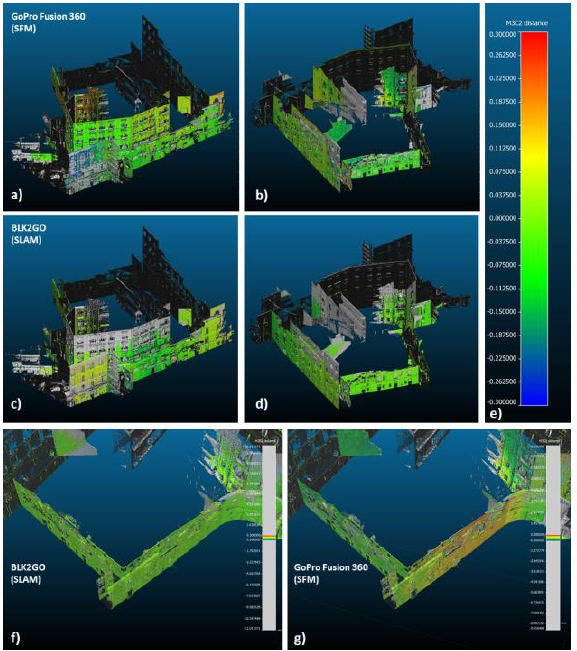
Figure 7 . M3C2 global analyses of SFM cloud (a, b) and SLAM cloud (c, d). The scalar field (e) ranges from blue (-30